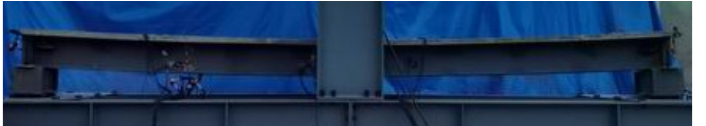
Figure 15. The uniaxial constitutive relationship of the FE model.